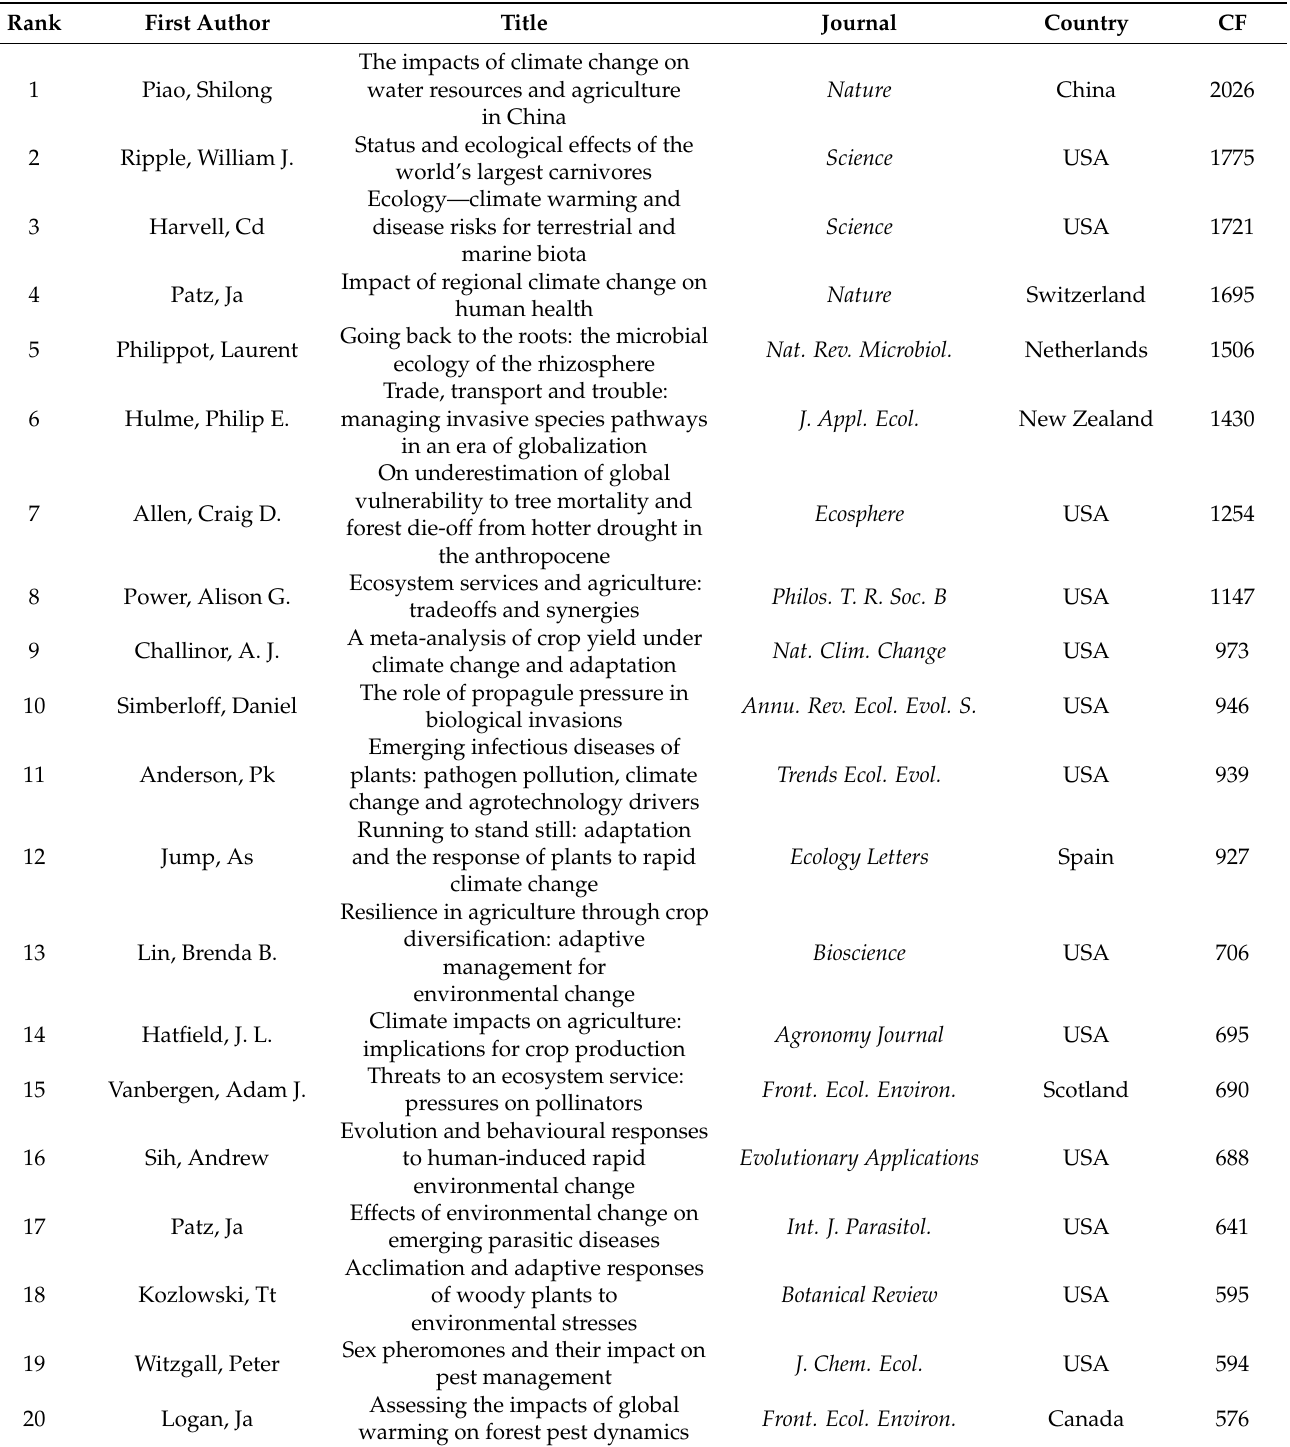
Table 6. Top 20 highly cited